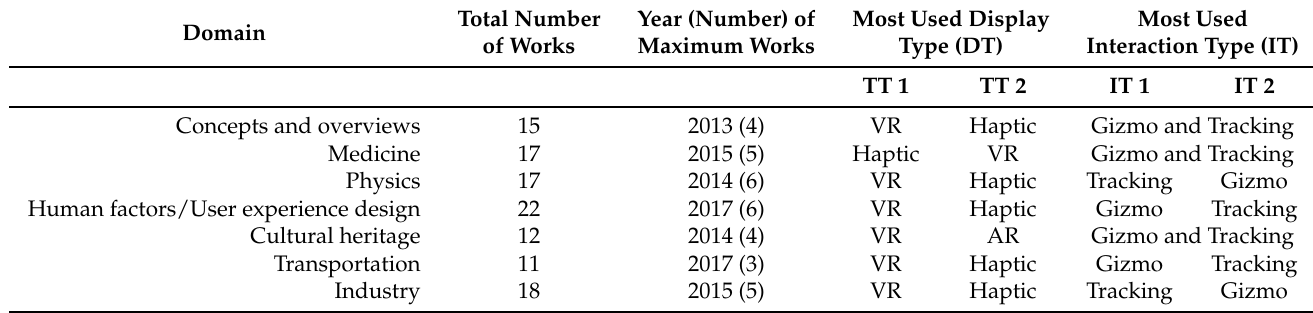
Table 10. Total number of reviewed papers by domain, most used display types and interaction